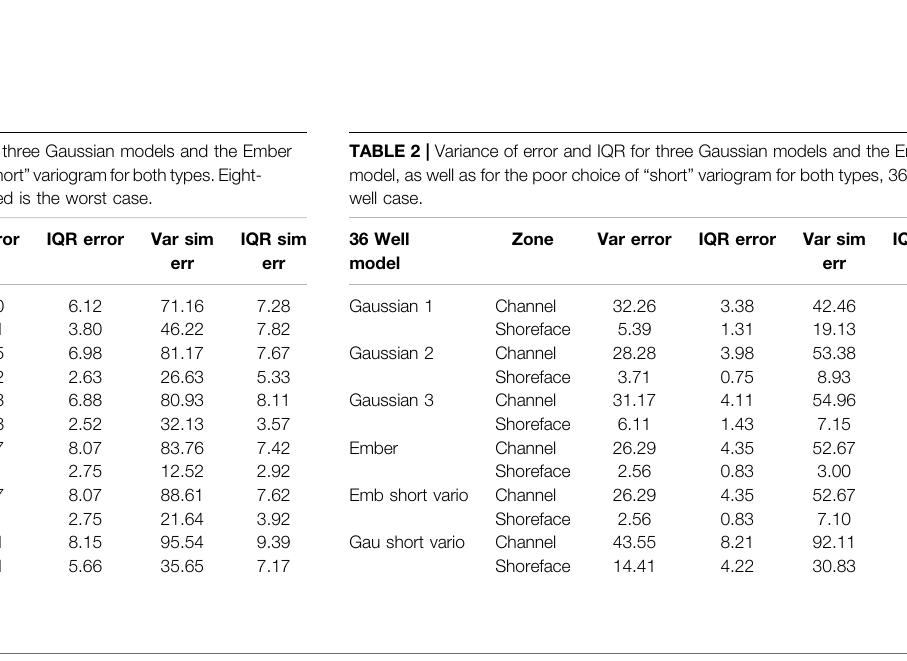
Frontiers in Arti fi cial Intelligence |